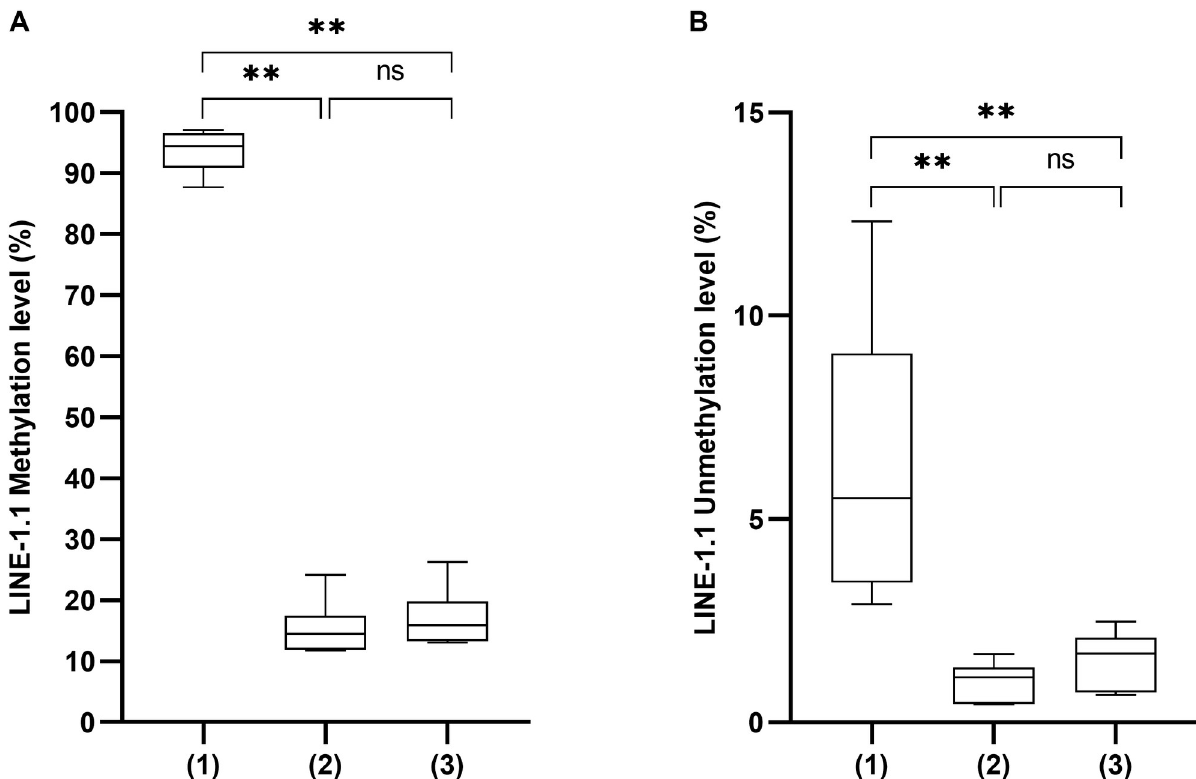
Fig 3. The methylated (A) and unmethylated (B) percentage of LINE-1 . 1 sequences calculated by three formulas (1), (2) and (3) (see text) using 5 ng of DNA extracted from FFPE samples and bisulfite converted. ( � ) p < 0.05; ( �� ) p < 0.01; ( ��� ) p < 0.001; ( ���� ) p < 0.0001. Statistical analysis was done by one-way